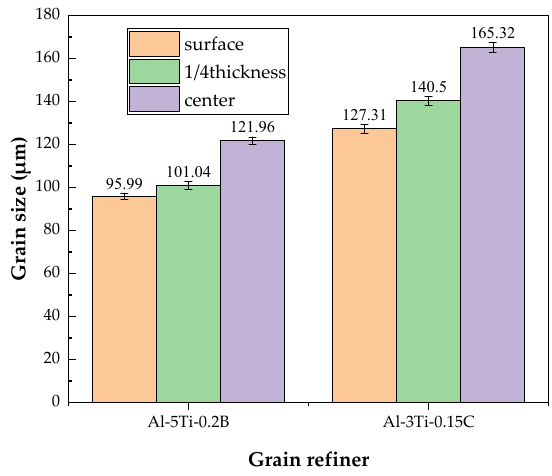
Figure 5. Average grain size for ingot using different grain refiners.